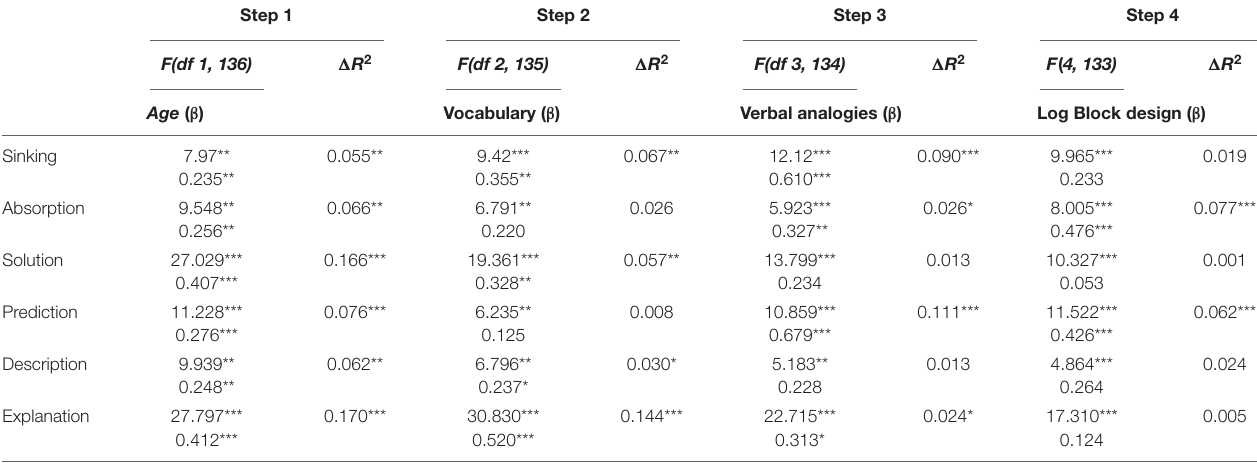
TABLE 3 | Hierarchical regression models of the relationships between cognitive ability and causal measures as dependent variables ( N = 138). Step 1